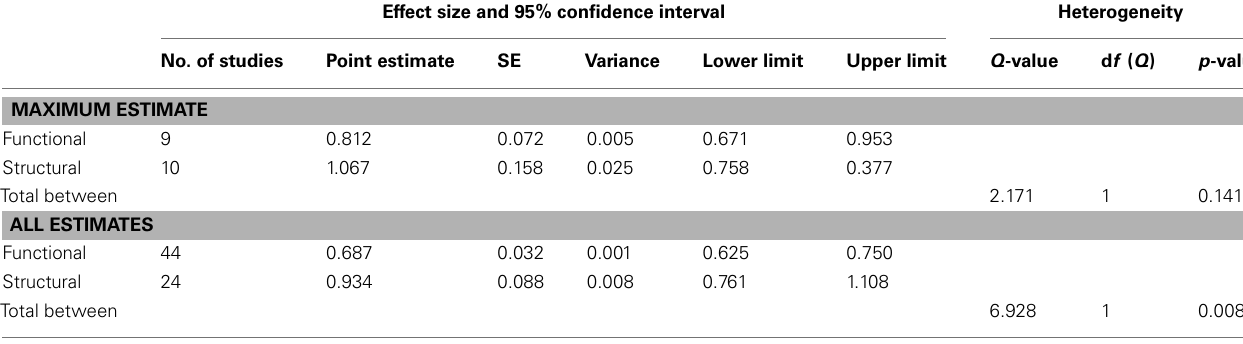
Table 3 | Results of random-effects meta-analysis comparing the relative difference in the impact of variants on functional and structural